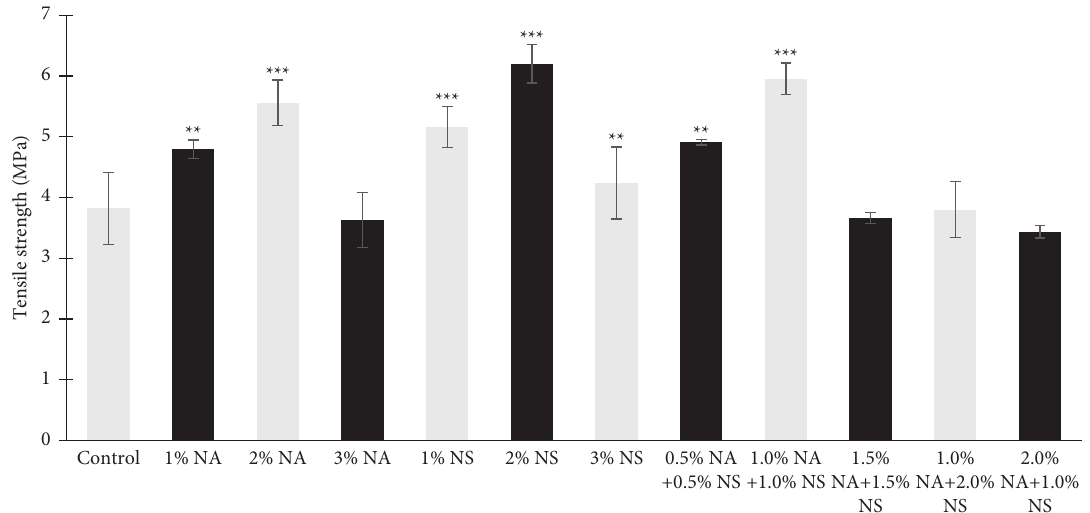
Figure 2: Tensile strength for diferent wt. % of nanoalumina (NA), nanosilica (NS), and hybrid nanoparticle HySA. ∗∗ P < 0 . 01, ∗∗∗ P < 0 . 001.